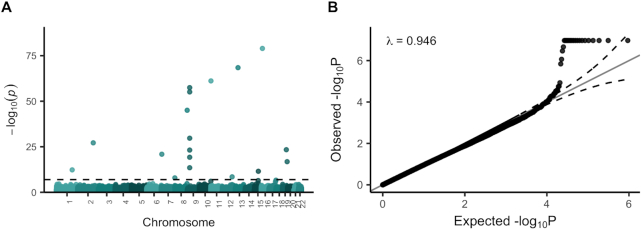
EWAS on C9 status within ALS patients. (A) Manhattan plot comparing association P-values (−log10(P), y-axis) and genomic location (x-axis). The dashed line indicates the bonferroni significance threshold (1.1 × 10−7). (B) QQ-plot showing observed P-values (−log10(P), y-axis) against the expected distribution under the null (x-axis). For presentation purposes P-values <1.1 × 10−7 are plotted as 1.1 × 10−7.